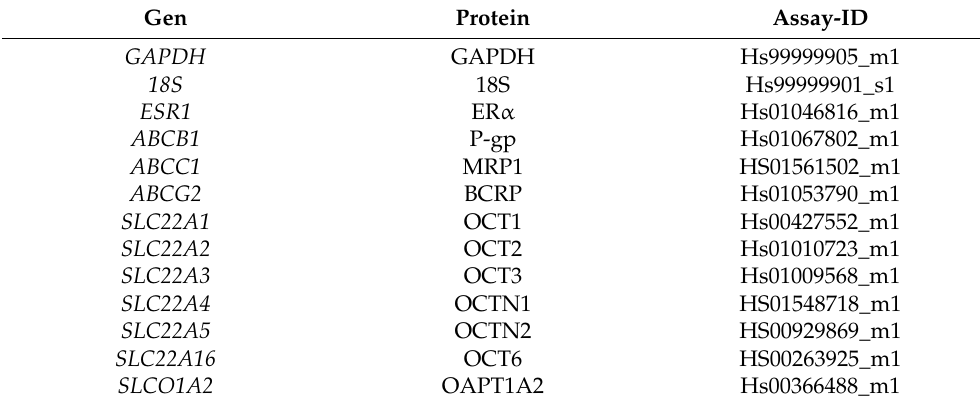
Table 2. Gene assays used for real-time PCR.